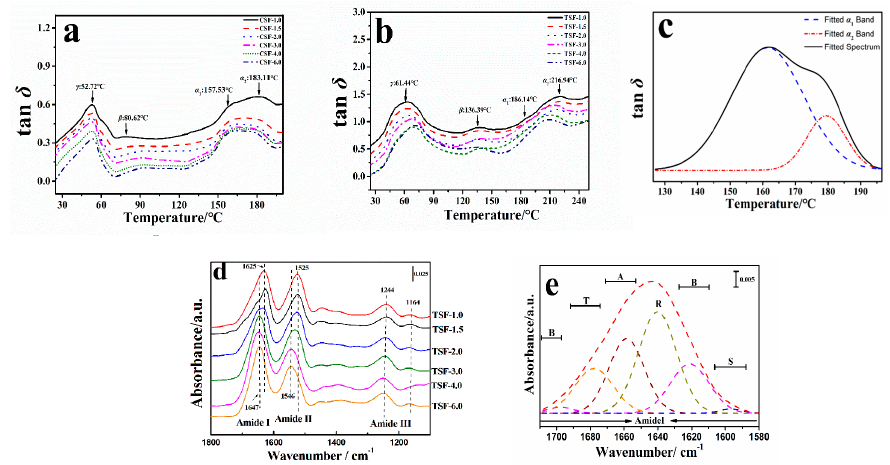
Figure 2. Tan δ curves of CSF ( a ) and TSF ( b ) from 1.0% (Solid); 1.5 (Dash); 2.0 (Dot); 3.0 (Dash Dot); 4.0 (Short Dot); 6.0 (Dash Dot Dot) CaCl 2 /FA; ( c ) Curve fitting example of the T g region (sample TSF-3.0). The fitted peaks are shown as Dash ( α 1 Peak) and Dash Dot Dot ( α 2 Peak); ( d ) FTIR absorbance spectra of TSF samples from different CaCl 2 conctration solutions in the range of 1100–1800 cm − 1 ; ( e ) Curve fitting example of the amide I region (sample TSF-3.0) in FTIR spectra. The fitted peaks were shown as short dash-dotted lines, and assigned as side chains (S), β -sheets (B), random coils (R), α -helixes (A), and turns (T).